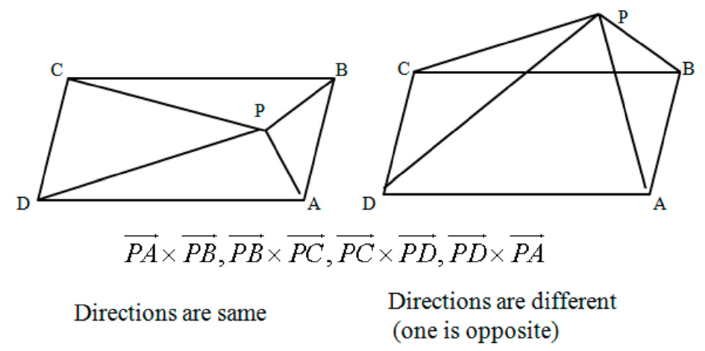
Figure 4. Shading states of P.